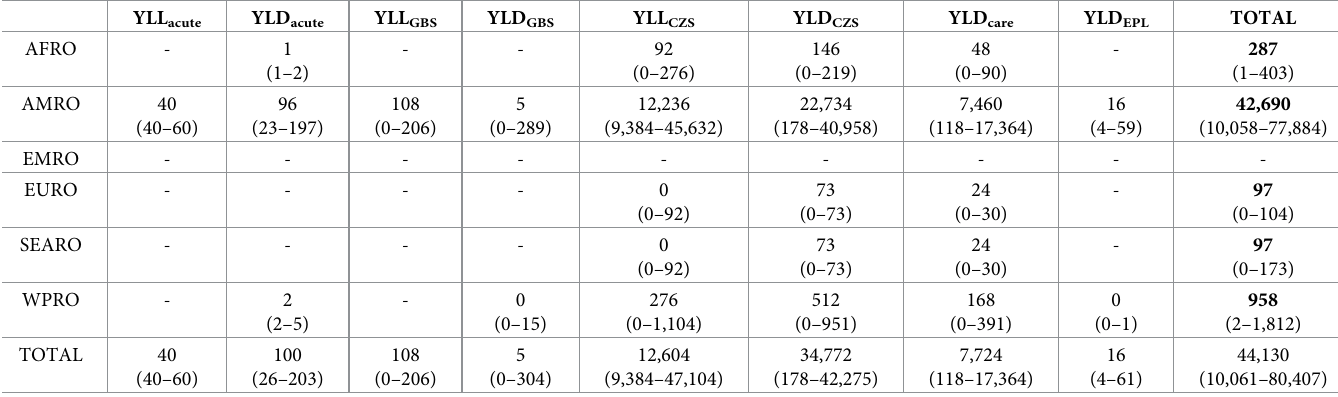
Table 4. DALY estimates for ZIKV.